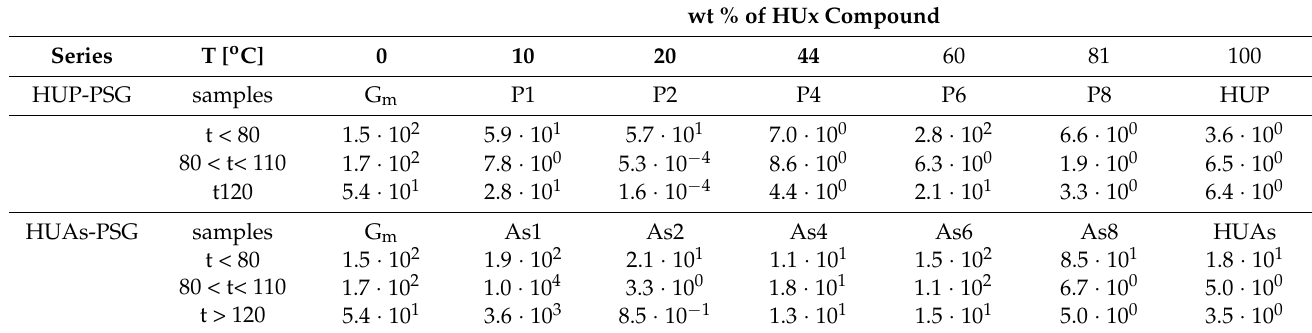
Table 5. Average values of the R 1 /R 2 ratio in various temperature ranges determined for all the systems